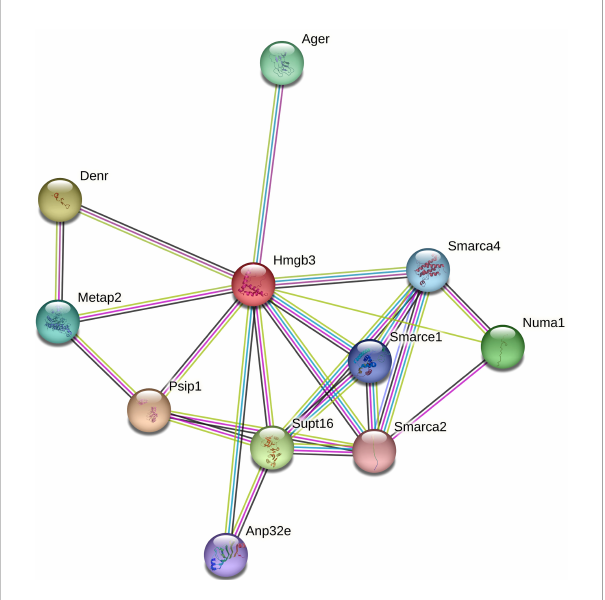
FIGURE 1 The protein-protein interaction network of HMGB3. The protein-protein interaction analyses were performed using the STRING database. Shown are HMGB3 (High Mobility Group Protein B3) and its top 10 protein interactors (listed clockwise): Ager (Advanced glycosylation end product-speci fi c receptor), Smarca1, Smarca2, and Smarca4 (SWI/SNF related, matrix associated, actin dependent regulator of chromatin, subfamily A members 1, 2 and 4, respectively), Numa1 (Nuclear mitotic apparatus protein 1), Supt16 (Component of the FACT complex), Anp32e (Acidic leucine-rich nuclear phosphoprotein 32 family member E protein), PsiP1 (PC4 and SFRS1-interacting protein), Metap2 (Methionine aminopeptidase), and Denr (Density-regulated protein). Different line colors represent different types of interaction evidence between the proteins.